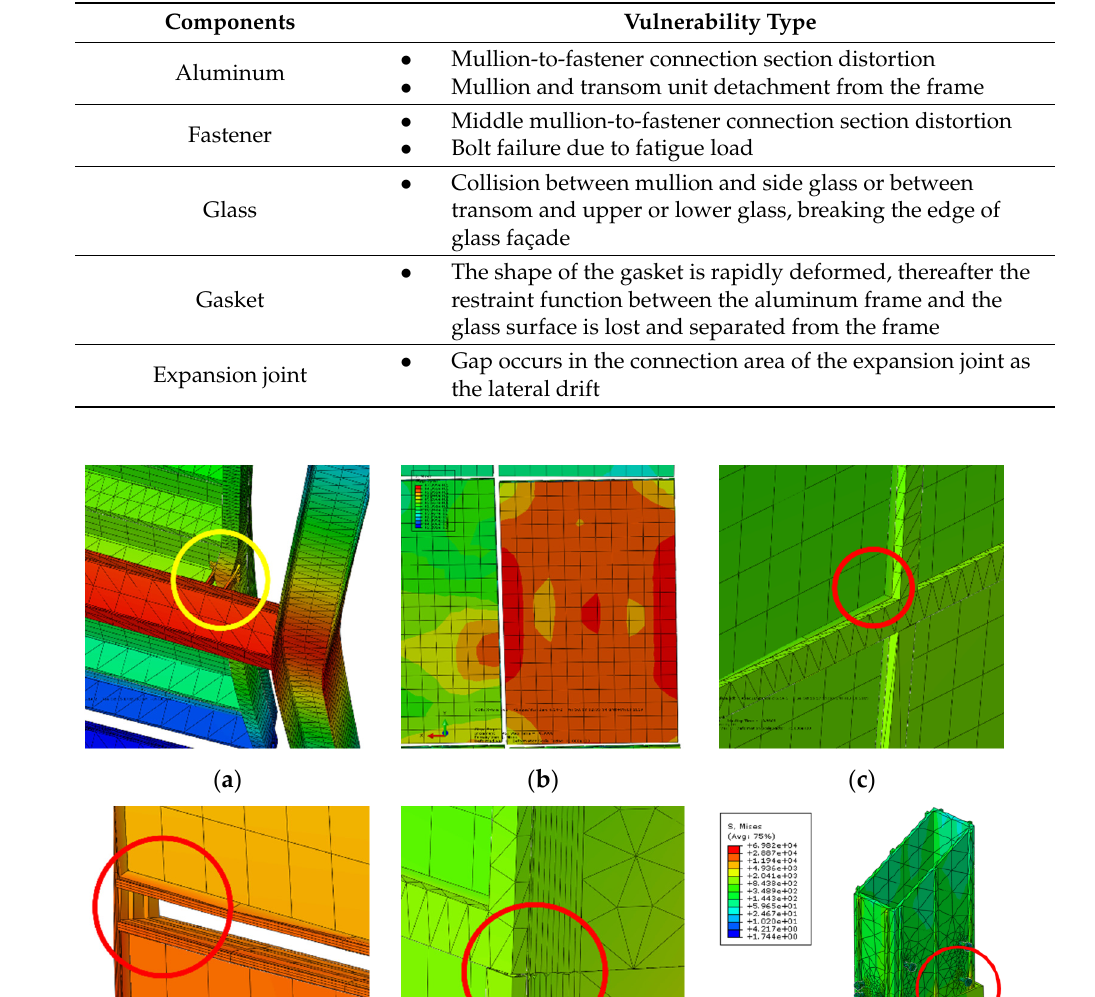
Table 8. Vulnerability analysis of conventional curtain wall components.